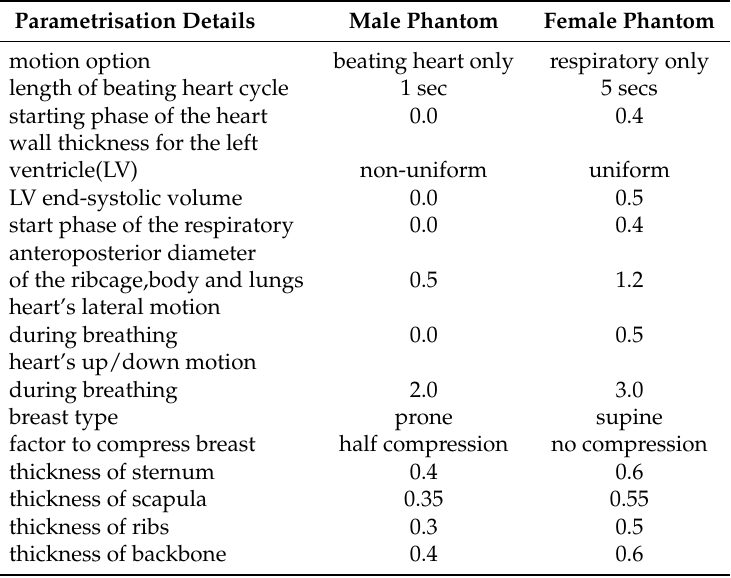
Table 4. The details of anatomical and motion parameters for male and female